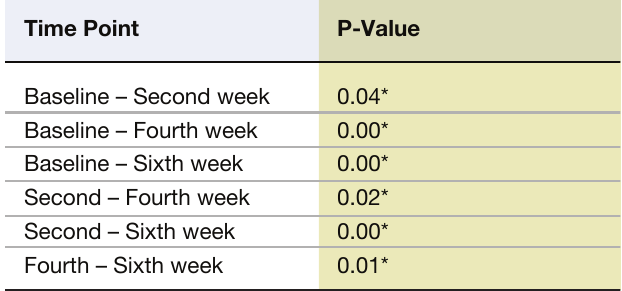
Baseline, Second, Fourth and Sixth Week of